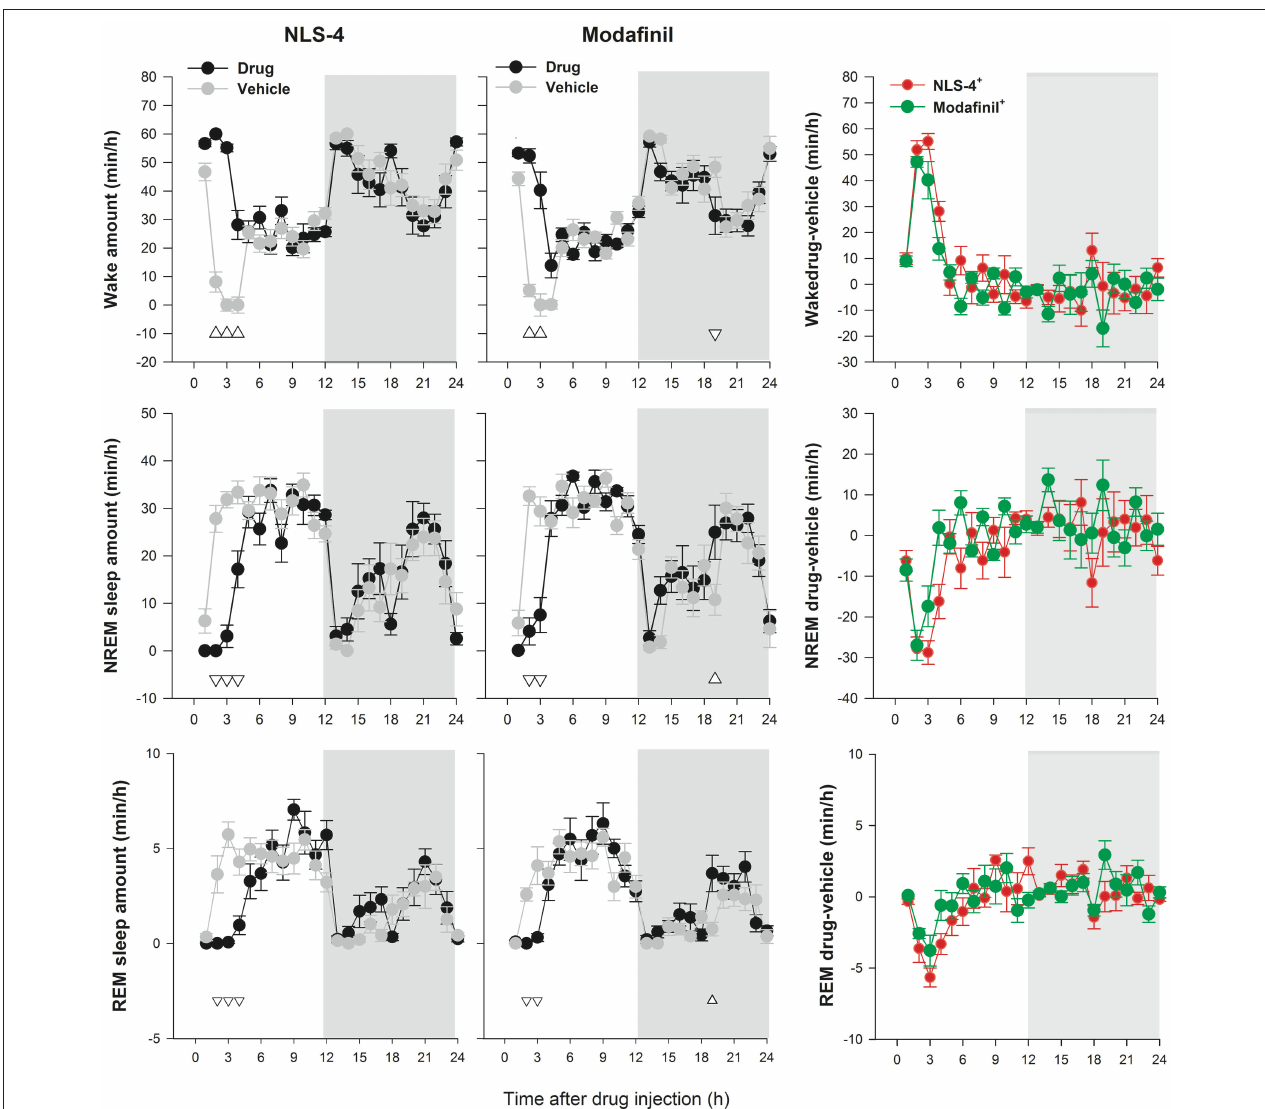
FIGURE 2 | Hourly distribution of vigilance states after NLS-4, modafinil, and vehicle administration (mean ± SEM). After initial suppression of NREM sleep by both drugs [2-way repeated measures ANOVA, NLS-4: “treatment” p < 0.0001, F (1, 7) = 73.25, “hour”, p < 0.0001, F (23, 161) = 17.21, interaction, p < 0.0001, F (23, 161) = 4.16; modafinil: “treatment” p > 0.38, F (1, 7) = 0.89, “hour” p < 0.0001, F (23, 161) = 20.18; interaction, p < 0.0001, F (23, 161) = 5.10], the distribution of NREM sleep during recovery is very similar to that after vehicle indicating the absence of sleep rebound (hypersomnia). Nevertheless, comparisons between the two drugs indicated significantly less NREM sleep after NLS-4 administration as compared to modafinil [2-way ANOVA, drug effect: F (1, 14) = 7.31, p < 0.02]. REM sleep is also suppressed during the first hours after drug injection while wakefulness is increased. Upward and downward triangles indicate significant increase or decrease, respectively. Shaded areas indicate the dark period. + indicates drug/vehicle